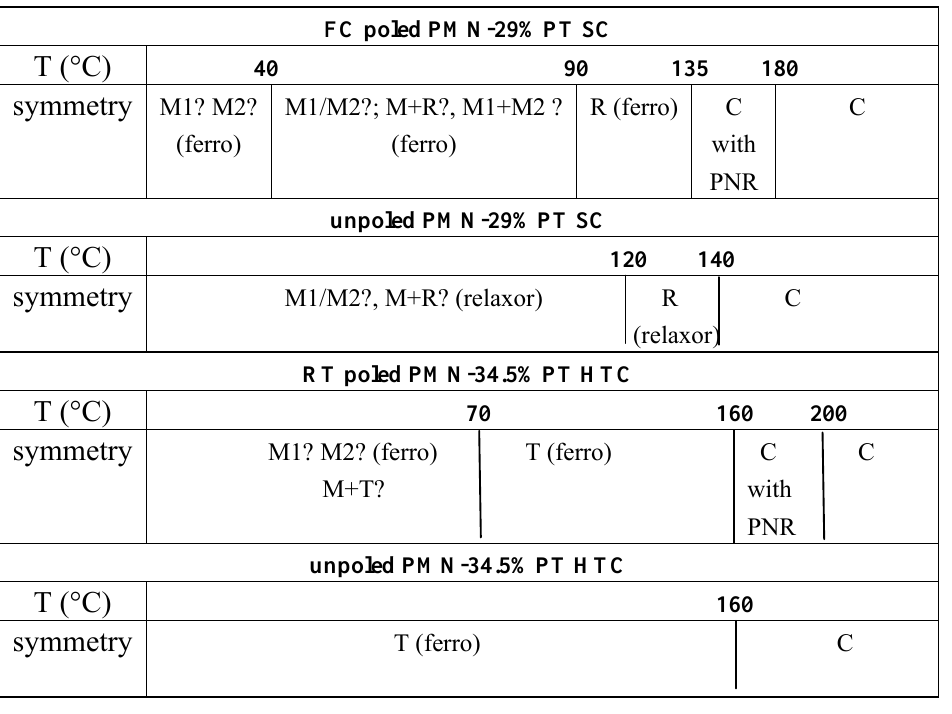
Table 1. Phase transition in the 20–250 °C temperature range detected for poled